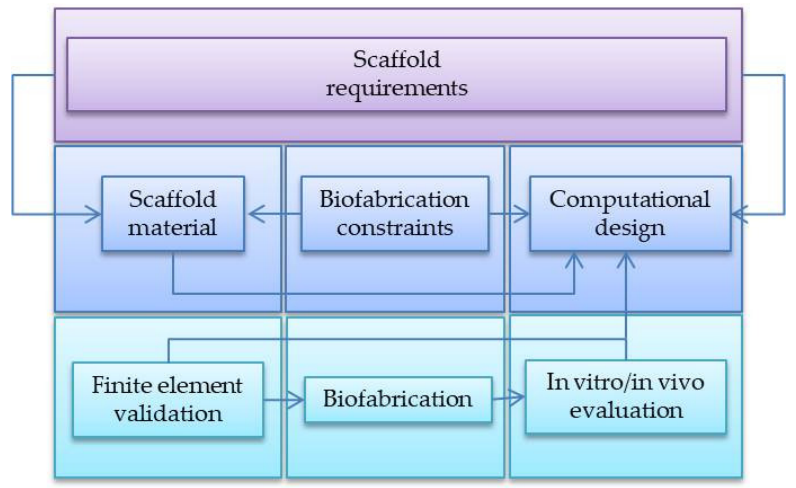
Figure 8. General idea of CATE (based on